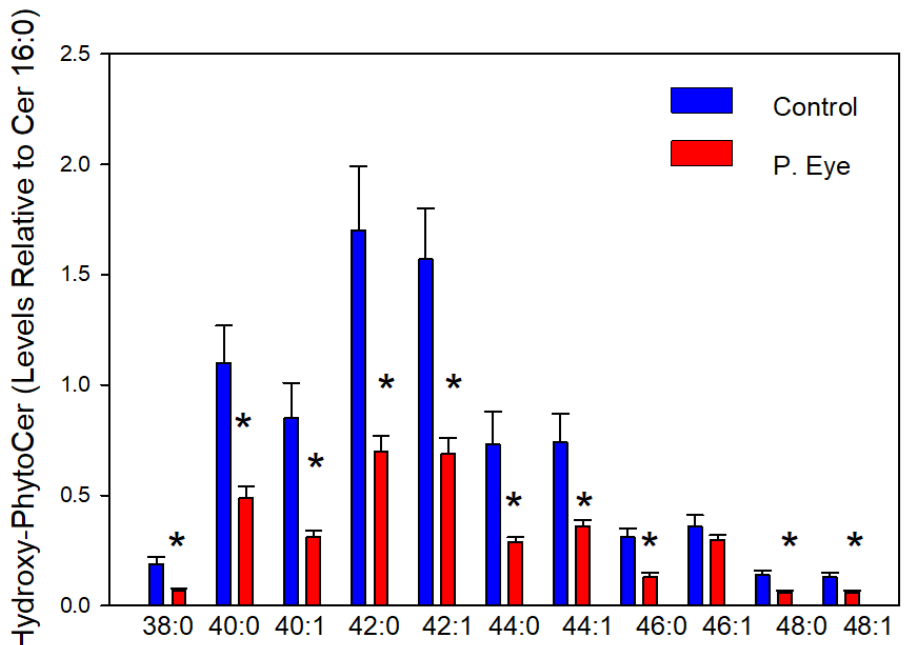
Figure 4. Tear film levels of hydroxy-phytoceramides (CerX-O4) in controls and cows with pink eye (P. Eye). The peak intensities of individual hydroxy-phytoceramides are expressed as a ratio of the peak intensity of ceramide d18:1/16:0. *, significant t -test statistics: 38:0-O4 (0.0064), 40:0-O4 (0.0056),